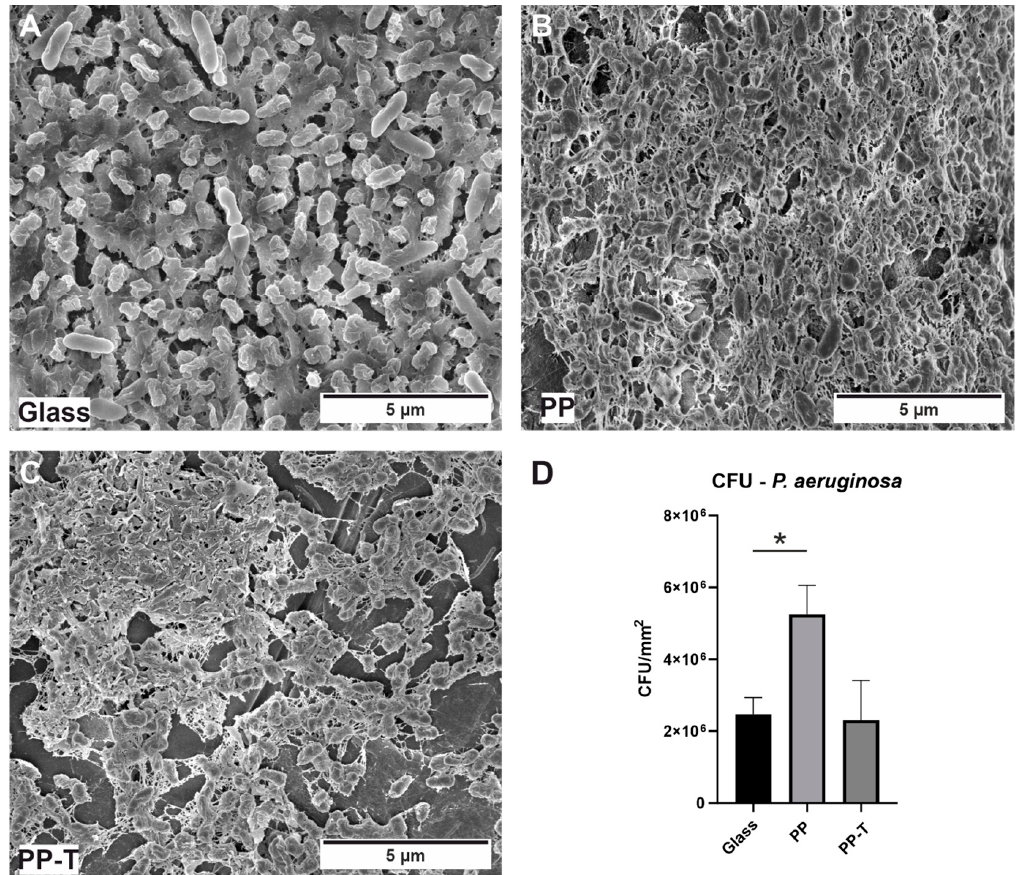
Figure 4. Bacterial attachment on the unaged as received polypropylene samples. SEM image of ( A ) P. aeruginosa attached to a reference glass sample, ( B ) unfilled PP, and ( C ) talc filled PP-T. ( D ) Quantification of the attached P. aeruginosa onto the surfaces by CFU Assay. Mean ± standard error of the mean was statistically analysed by Mann–Whitney U tests (* p ≤ 0.05).